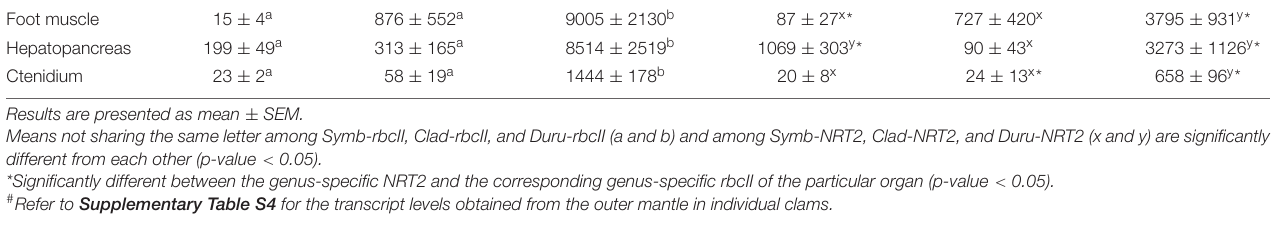
TABLE 3 | Transcript levels (copies of transcript per ng of total RNA) of form II ribulose-1,5-bisphosphate carboxylase/oxygenase (rbcII) and nitrate transporter 2 (NRT2) derived from Symbiodinium ( Symb-rbcII and Symb-NRT2 , respectively), Cladocopium ( Clad-rbcII and Clad-NRT2 , respectively) and Durusdinium ( Duru-rbcII and Duru-NRT2 , respectively ) in the outer mantle, inner mantle, foot muscle, hepatopancreas, and ctenidium ( n = 13) of Tridacna squamosa . Organ Transcript levels (copies of transcript per ng of total RNA) Symb-rbcII Clad-rbcII Duru-rbcII Symb-NRT2 Outer mantle # 1409 ± 222 a 21190 ± 10391 a Inner mantle